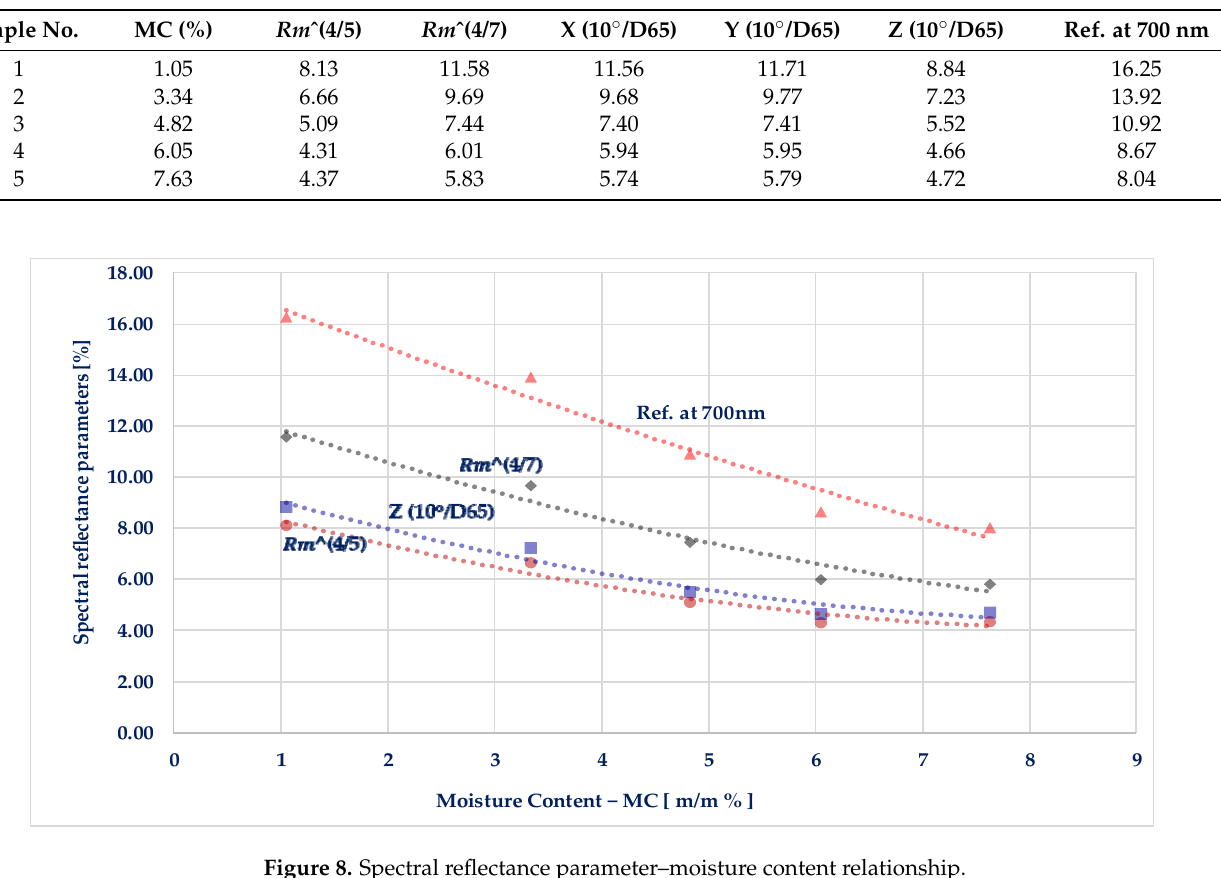
Table 2. This table shows some important spectral reflectance parameters.